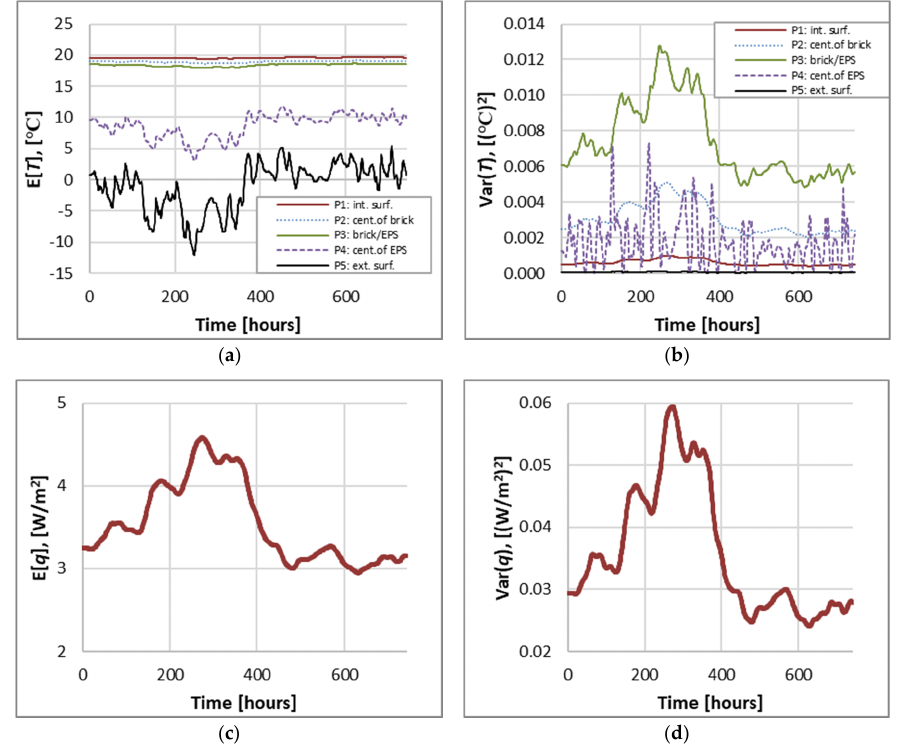
Figure 8. ( a ) Expected value and ( b ) variance of temperature in 5 points in the wall and ( c ) expected value and ( d ) variance of heat flux on the internal side of the wall in January obtained using the perturbation method for Case 2.